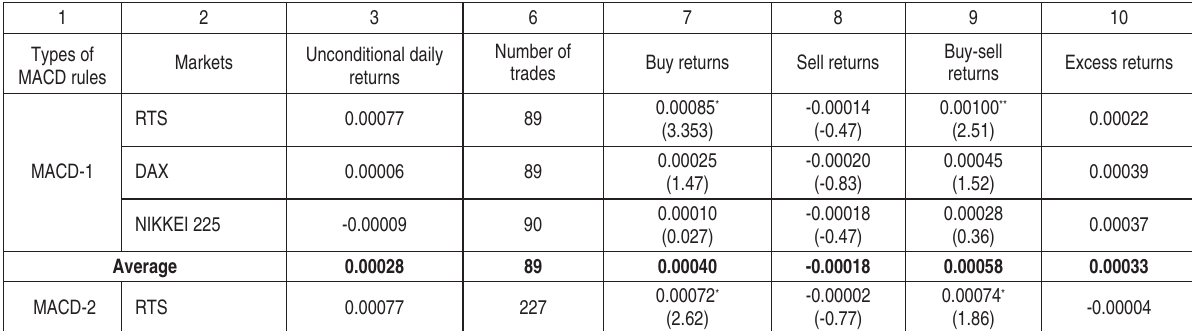
Table 4. Results of the four MACD trading strategies in the base